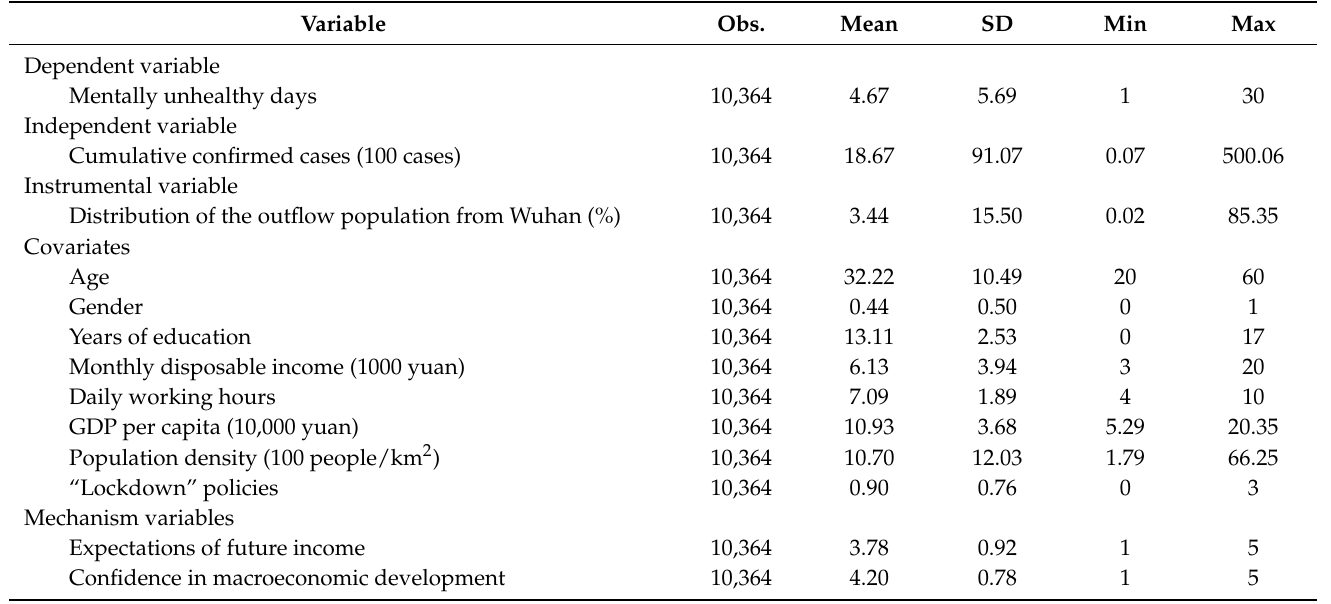
Table 1. Descriptive statistics of the main